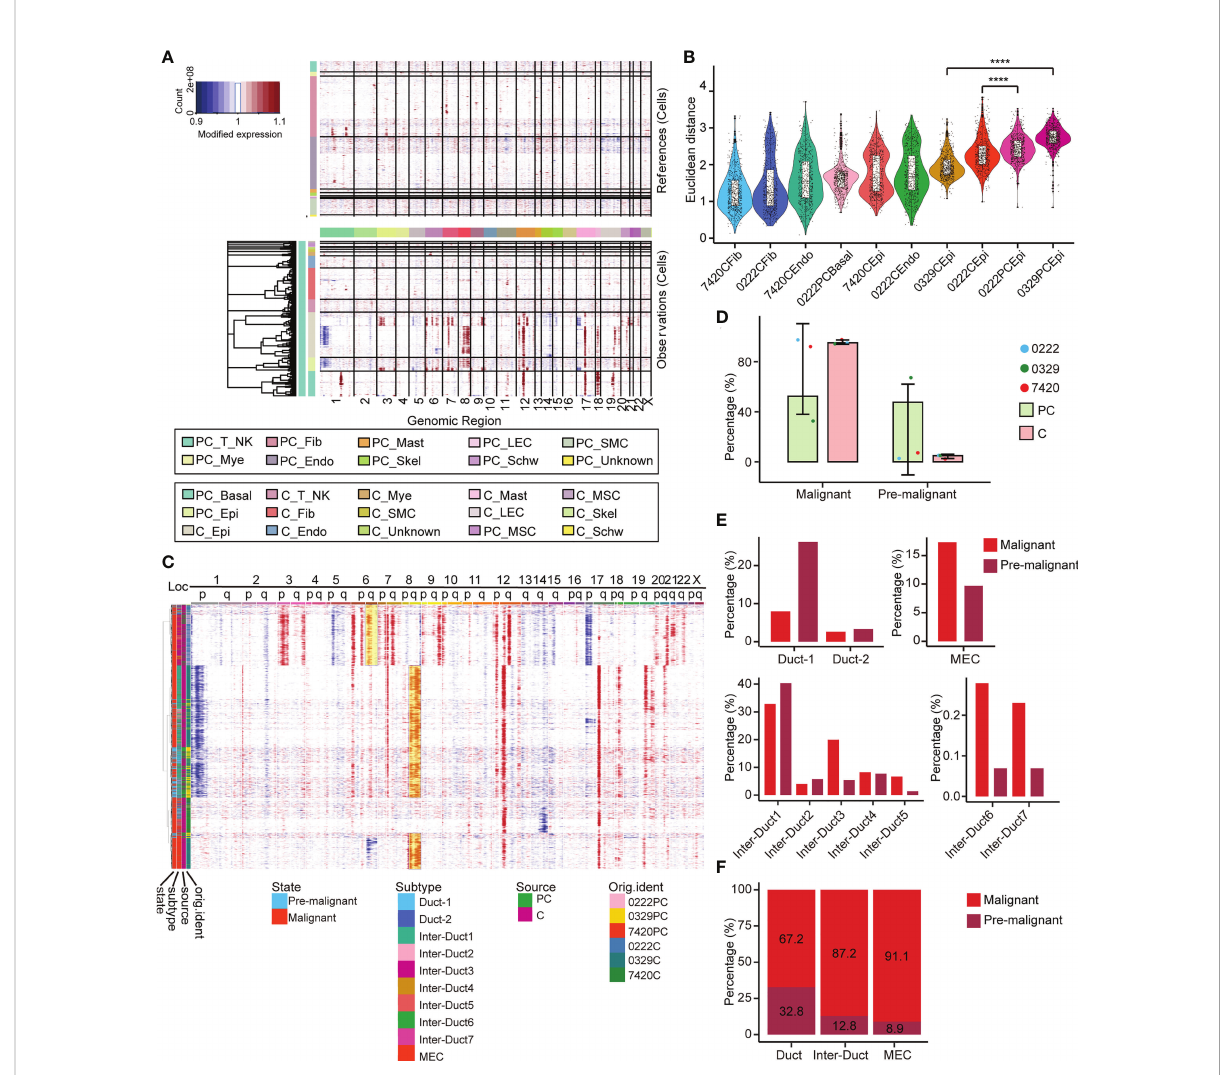
FIGURE 4 Multilayer heterogeneity of CNVs in epithelial cells. (A) Nonmalignant cells were used as references (top) and large-scale CNVs were observed in epithelial and basal cells (bottom). (B) A total of 600 epithelial cells, endothelial cells, basal cells, and fi broblasts were randomly selected from each corresponding sample and the Euclidean distance between the CNV score of which and the median CNV score of fi broblasts in adjacent samples was calculated and ranked respectively and presented as a scatterplot. All p-values were calculated by Wilcoxon rank sum test, **** p ≤ 0.0001. (C) Reclustering the CNV score matrix of the epithelial cells. Cell grouping information is annotated below. (D) The relative abundance of pre-M and malignant cells in PT and tumor tissues. Error bars are presented as mean ± SD. (E) The relative abundance of 10 epithelial cell subtypes in the pre-M and malignant cells. (F) The relative abundance of the three main epithelial cell populations in the pre-M and malignant cells. pre-M: pre-malignant, PC: paracarcinoma, C: